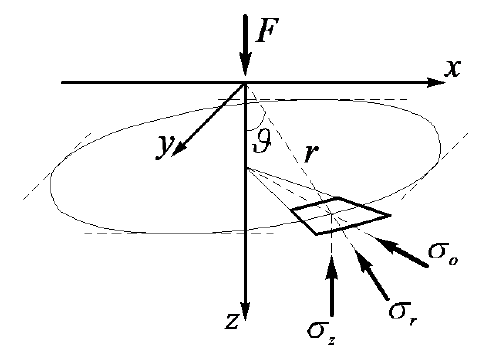
Figure 3: Parameter definition for Eq.